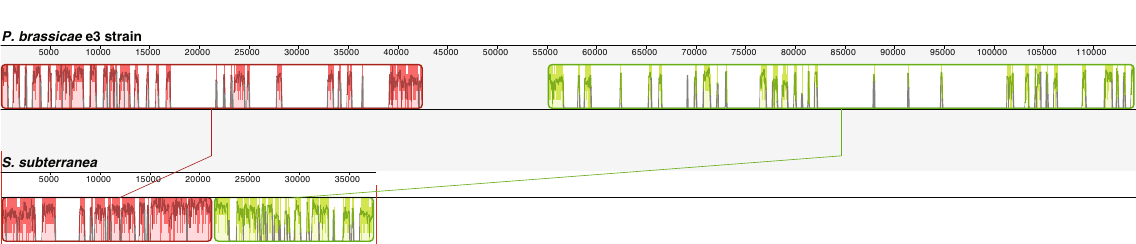
Figure 4. Synteny between the Plasmodiophora brassicae e3 and Spongospora subterranea mitochondrial genomes. The image 38 illustrates aligned mitochondrial sequences of P. brassicae e3 (upper panel) and S. subterranea (lower panel). Identified homologous regions are displayed as two locally collinear blocks (LCB), green and red. The LCBs with matching colors between the genomes are connected by lines. Inside each LCB, a sequence similarity profile is shown, with its height representing the average level of sequence conservation. White areas within a LCB indicate sequences that are unique to a particular genome. The region outside LCBs ( P. brassicae e3 sequence from 42,547 to 55,095 bp) has no detectable homology with the S. subterranea mitochondrial